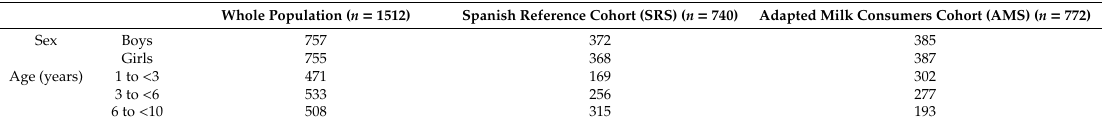
Table 1. Distribution of the studied sample in the Nutritional Study in Spanish Pediatric Population (EsNuPI) ( n = 1512)